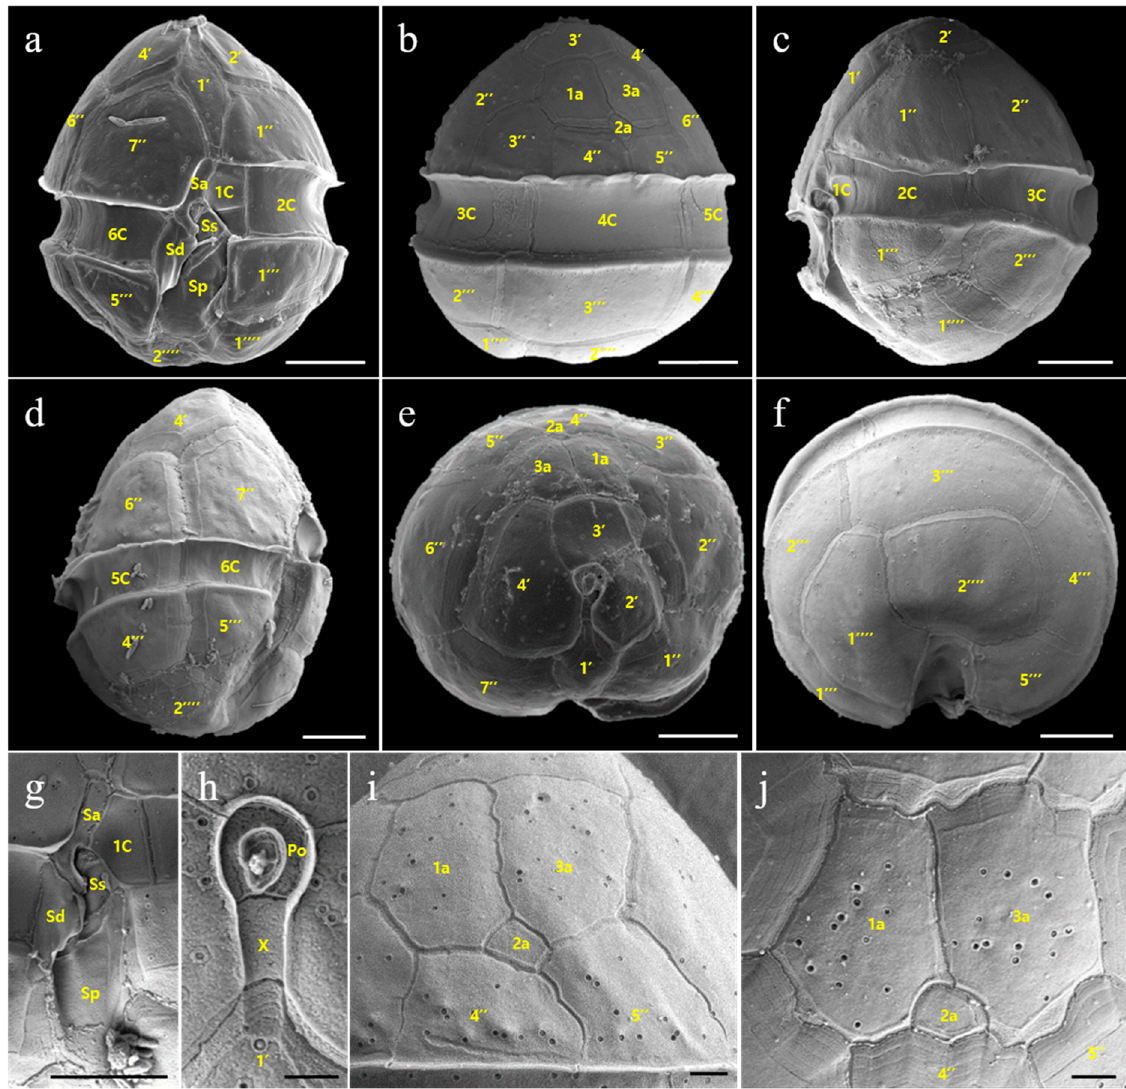
Figure 4. Scanning electron micrographs of Scrippsiella precaria (strain LIMS-PS-2799): ( a ) ventral view, ( b ) dorsal view, ( c ) left lateral view, ( d ) right lateral view, ( e ) apical view showing the apical pore (Po) and three intercalary plates, ( f ) antapical view showing the hypothecal plate pattern, ( g ) sulcal plates, ( h ) detail of Po, ( i ) detail of the 5 ʹʹ plate that contacted the 2a plate, and ( j ) detail of the 5 ʹʹ plate that did not contact the 2a plate. Scale bars: 5 µm ( a – g ) and 1 µm ( h – j ).